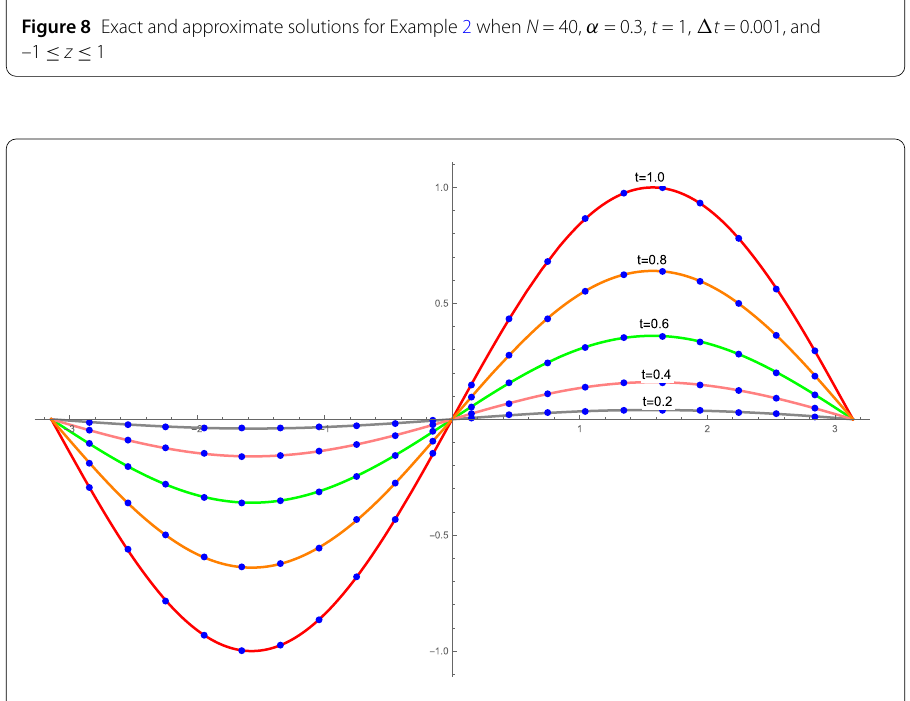
Figure 9 Exact and numerical solutions for Example 3 when N = 100, t = 1, (cid:3) t = 0.0001, α = 0.8, and – π ≤ z ≤